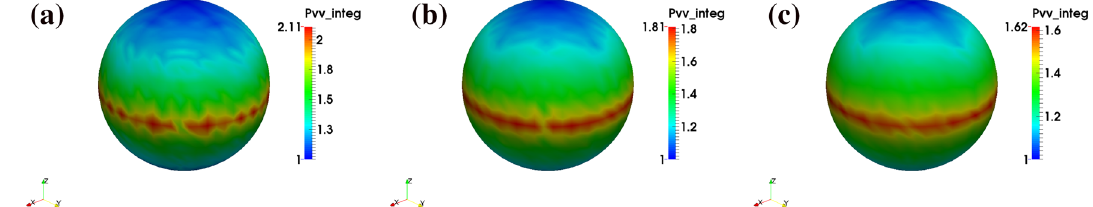
Fig. 5 The spatial distribution of the integrated P ii ð r Þ ( P ii ) for the insulation specimens: a L3 sample, b L6 sample, c L9 sample ( Note The values on colorbar represent the relative anisotropy for each direction.).